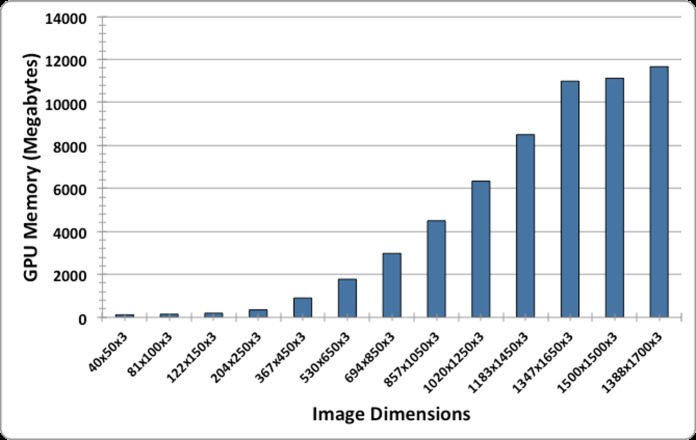
GPU memory size requirements (Megabytes) for different image dimensions (height × width × channels) for the experimentation of FCN based on CNN2 model.